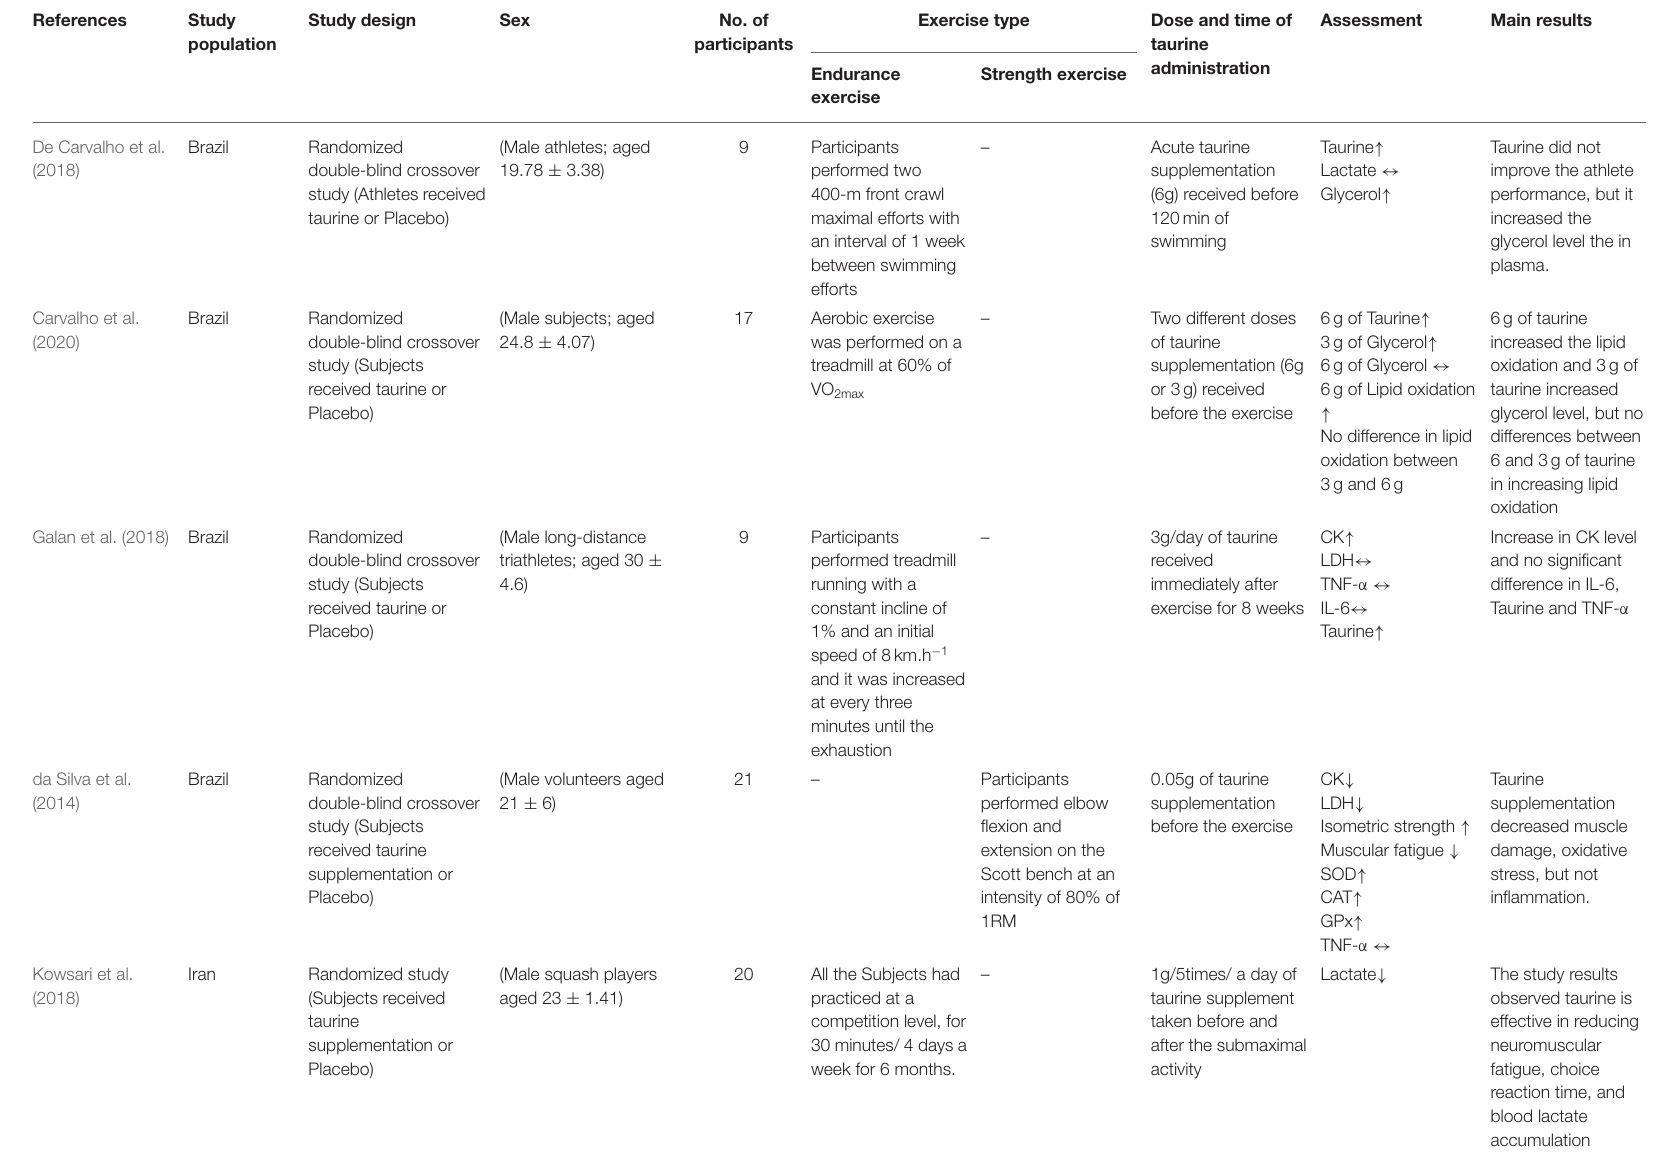
TABLE 4 | The study characteristics of included